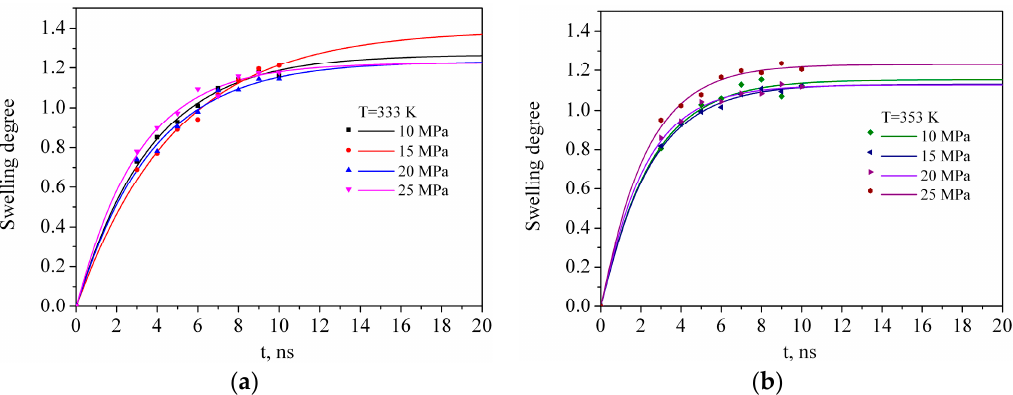
Figure 8. Dependence of polymer swelling degree (symbols) and theoretical approximations of the MD data according to Equations (7) (lines) at 333 K ( a ) and at 353 K ( b ). Table 5. The rate ( α max - the maximum degree of swelling, k - the swelling rate constant) of swelling from Equation (7) for all thermodynamic points. The numbers after ± denote the standard deviation. T, K P, MPa α max k 10 1.27 ± 0.02 0.28 ± 0.01 333